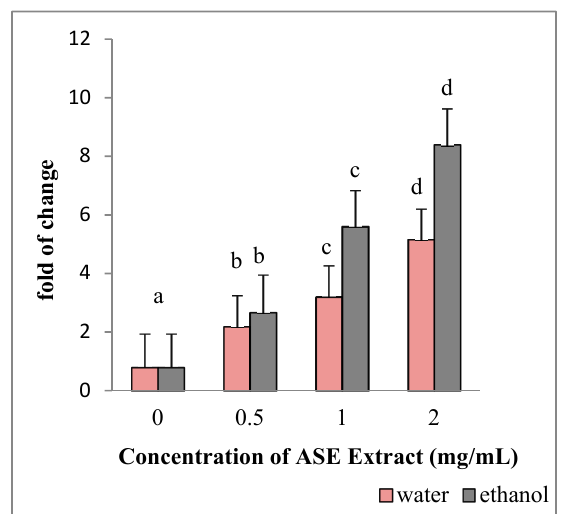
Figure 3. Effect of ASE crude extracts on Bax gene expression in HepG2 cells. The mRNA levels for each gene are expressed as fold of change (2 − ∆∆ Ct ) relative to the untreated control (defined as 1) (mean ± SD; n = 3) and normalized to the Glyceraldehyde-3-Phosphate-Dehidrogenase (GAPDH). Data are expressed as mean ± SD referred to the control. Bars marked by unlike letters within a group are significantly different at p < 0.05, according to Duncan’s Multiple Range Test (DMRT).